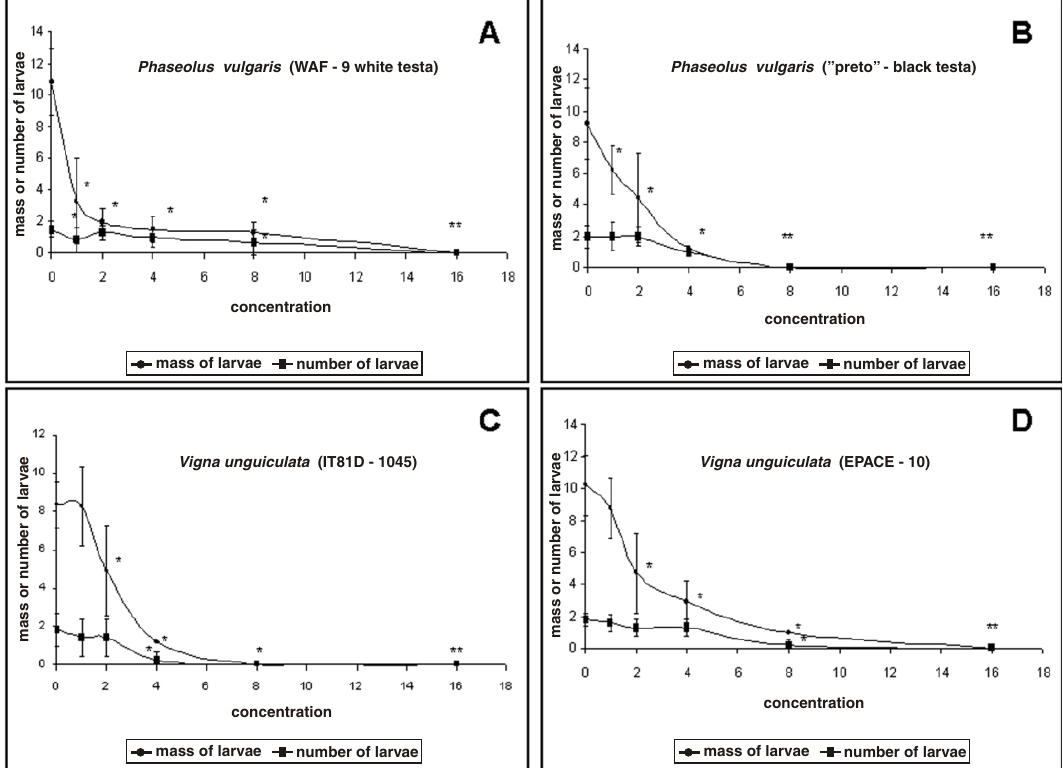
Fig. 1 – Effect of ground testa tissues of Phaseolus vulgaris and Vigna unguiculata seeds on Callosobruchus maculatus larval development weight and survival after 20 days. Powdered testa of the several seeds [(A) P. vulgaris (WAF-9); (B) P. vulgaris ‘‘preto’’ black testa; (C) V. unguiculata (EPACE-10); (D) V. unguiculata (IT81D-1045)] were incorporated into artificial seeds in different concentrations (1.0, 2.0, 4.0, 8.0 and 16.0%). Error bars represent independent SEM (*indicates values significantly different, p ≤ 0 ,